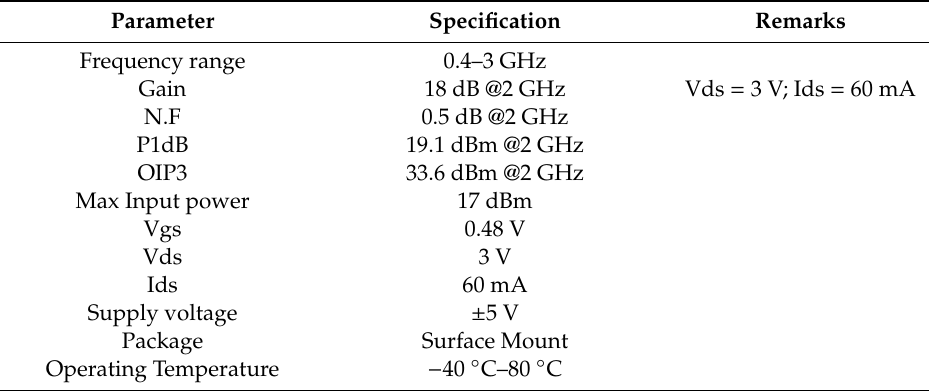
Figure 9. S21 of an Active Circular Receiving Patch antenna. Table 1. Low noise amplifier (LNA) specification at S band.